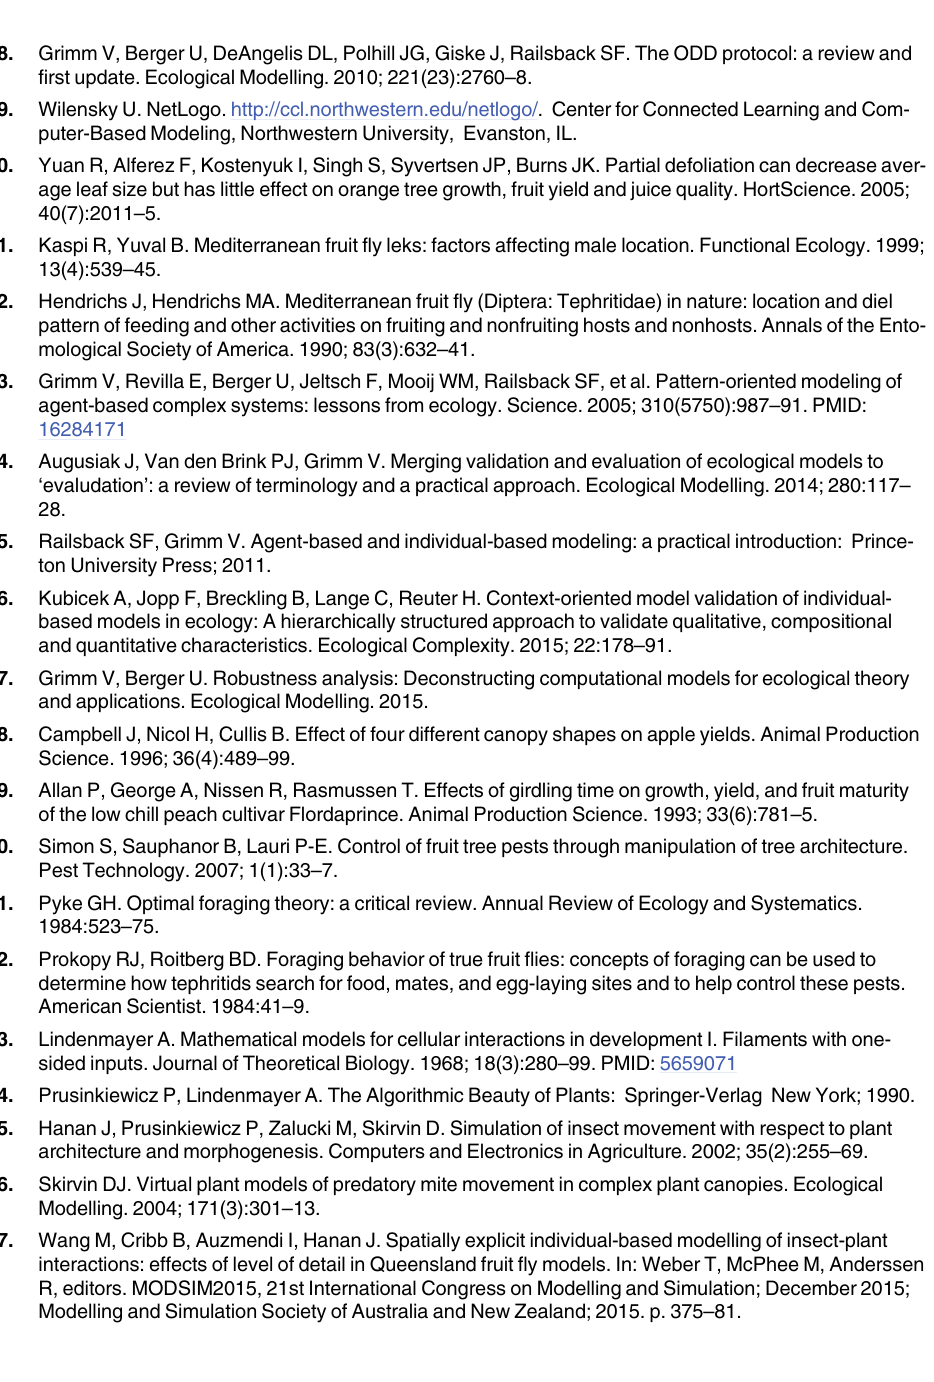
PLOS ONE | DOI:10.1371/journal.pone.0151777 March 21,